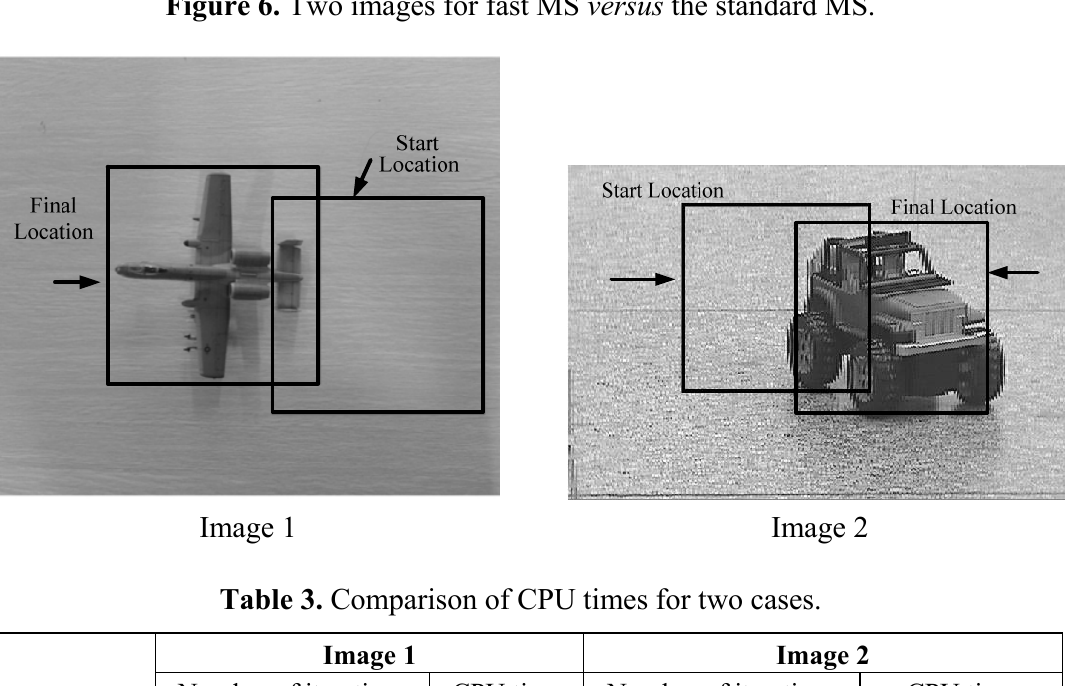
Figure 6. Two images for fast MS versus the standard MS.